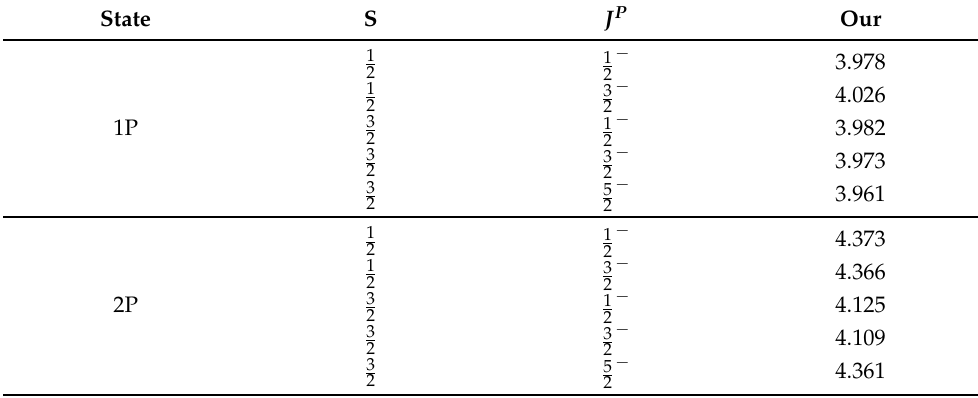
Table 3. Orbital excited state masses (in